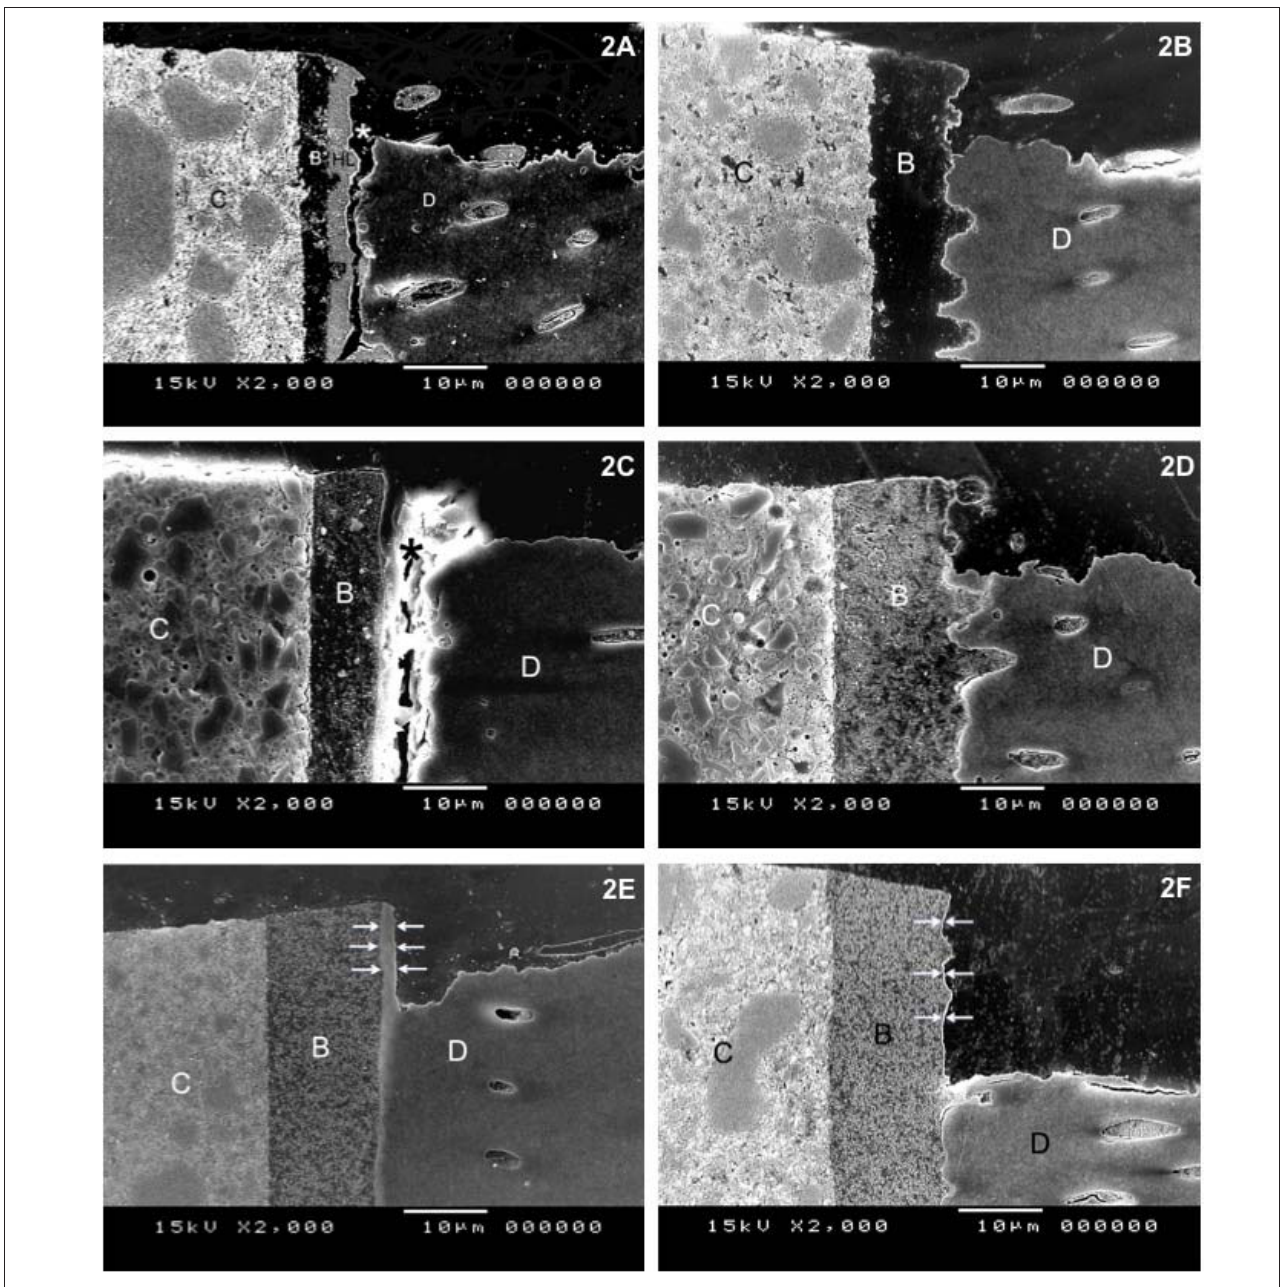
Fig. 2. SEM observations of the adhesive-dentin interfaces after acid-base challenge (x2.000). A- Clearfil Photo Bond, B- Clearfil Photo Bond applied after 10% NaOCl, C- One-Step Plus, D- One-Step Plus applied after 10% NaOCl, E- Clearfil SE Bond and F- Clearfil SE Bond/10% NaOCl (C: composite; B: adhesive layer; HL: hybrid layer; D: dentin; *: hybrid layer destroyed; arrows: acid-base resistant zone).